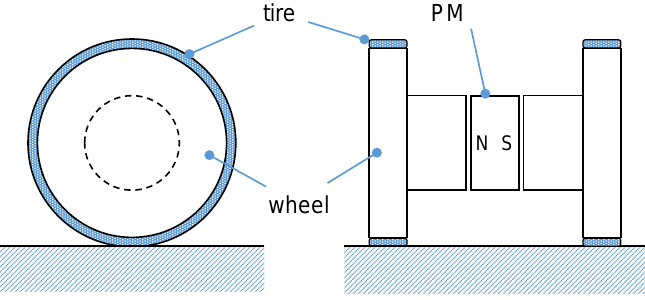
Figure 1. Structure of a simplified magnetic